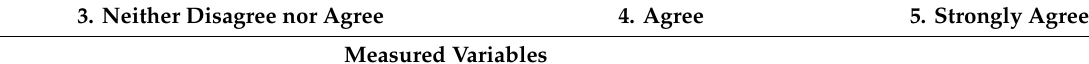
Table A2. Questionnaire of the study (translated from the Bangla language to the English